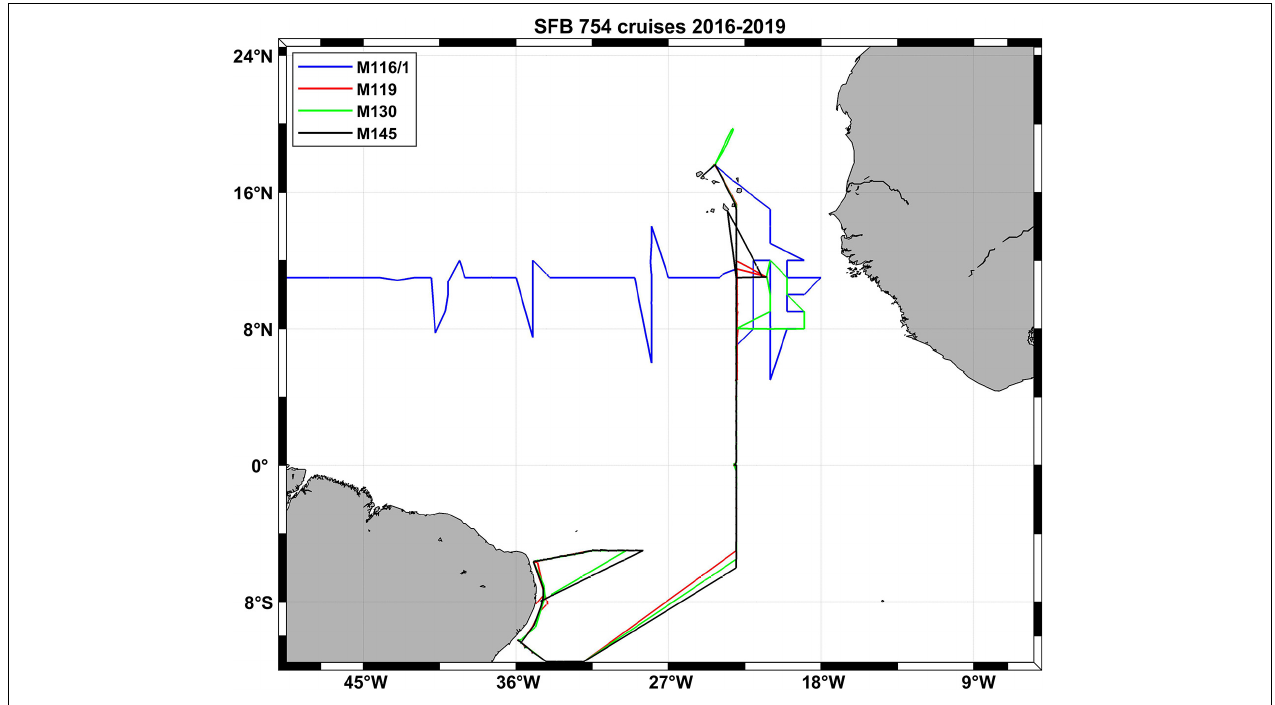
FIGURE 4 | Cruise tracks of four SFB 754 crusies in the Atlantic Ocean in the third funding period of the project